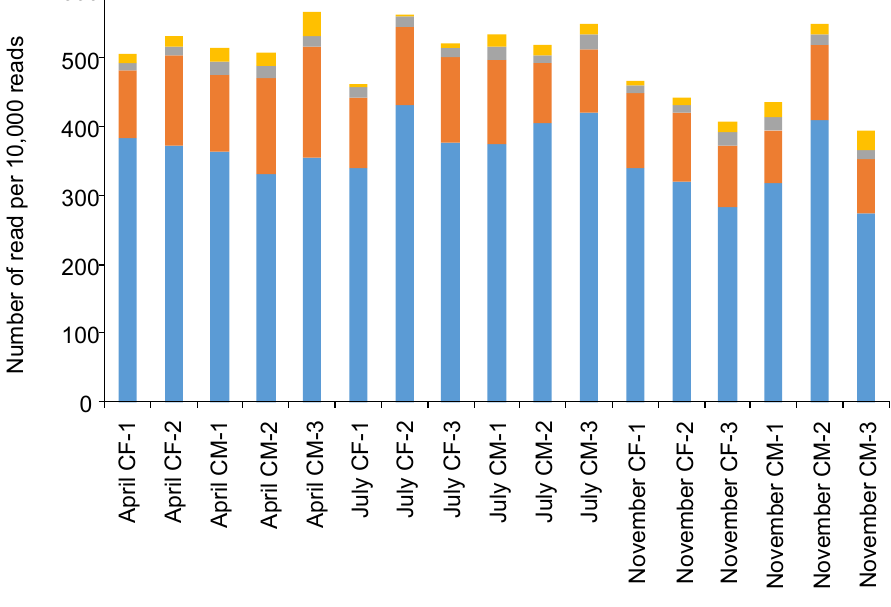
Figure 3. Number of 16S rRNA gene-sequence read identified as families to which PNSB belong in soil DNA collected from paddy fields. Soils were collected from the farm of the college of agriculture, Utsunomiya University, in April (plots before irrigation and plantation), July (plots during flooded culture with panicle initiation stage), and November (plots after harvest). CF and CM indicate chemical fertilizer and cow manure, respectively. DNA was extracted from soil using ISOIL for Beads Beating (Nippon gene, Tokyo, Japan). Metagenome sequencing was performed as described previously [114]. Sequence reads were processed and classified using Geneious Prime ver. 2019.2.3 (Tomy Digital Biology, Tokyo,